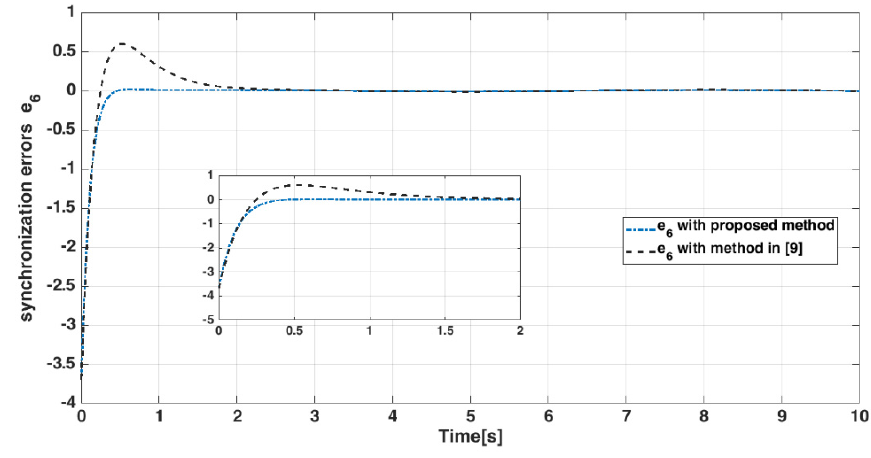
Figure 19. State error 𝒆 𝟔 of master-slave systems